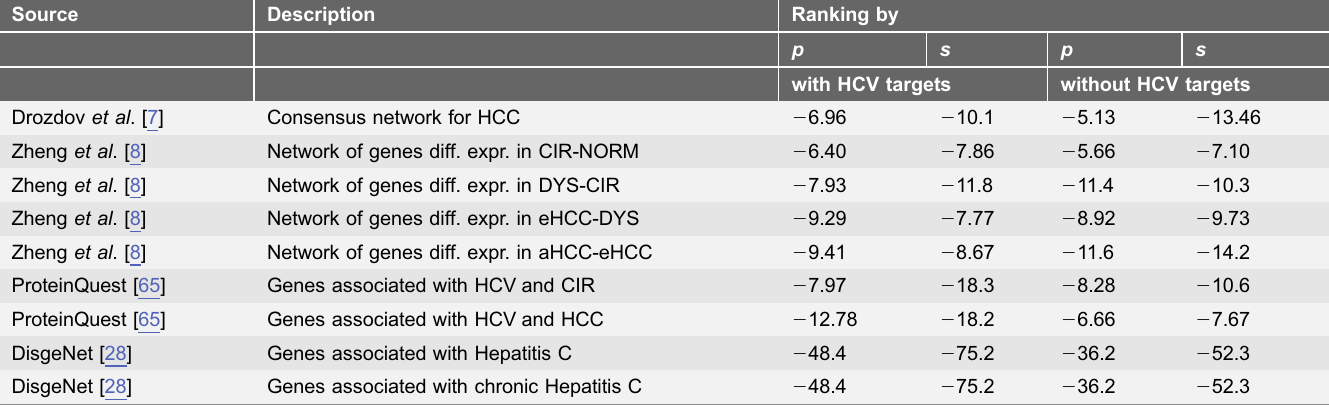
Table 1. Proteins in network proximity to HCV targets are highly enriched with lists of proteins proposed as regulators of host response to HCVand involved in HCC. Source